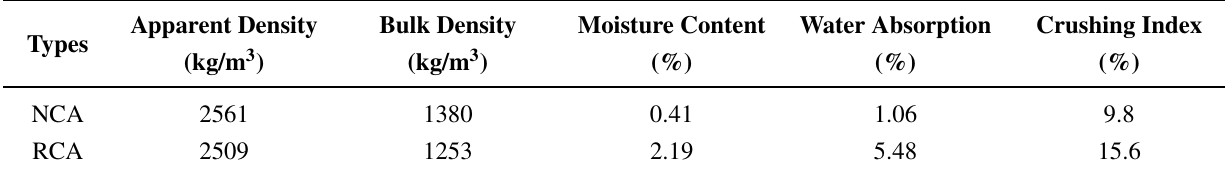
Table 4. Properties of coarse